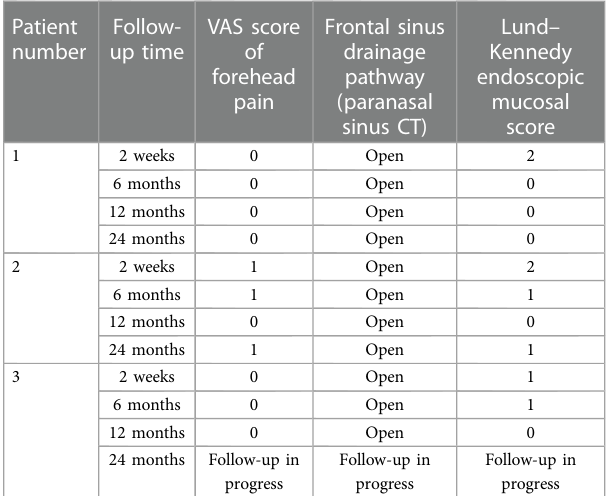
TABLE 3 Patients ’ postoperative condition.